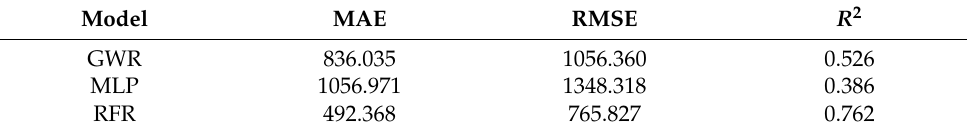
Table 2. Error comparison of simulation results of different